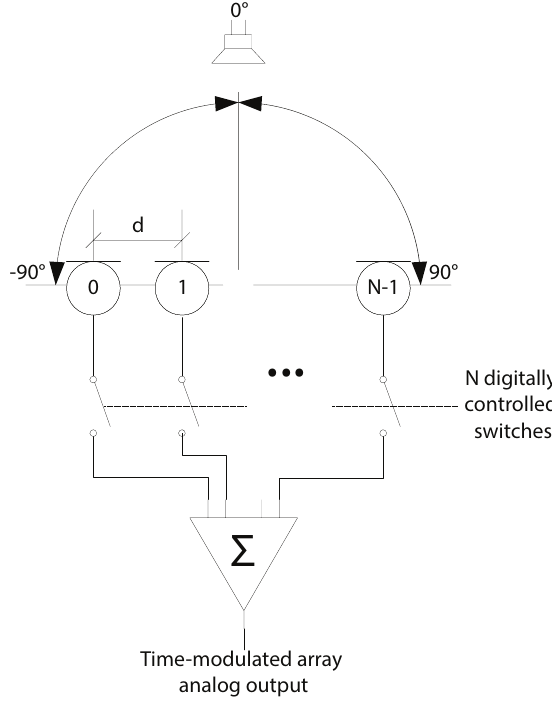
Figure 1. Typical schematic of an N element time-modulated array with d